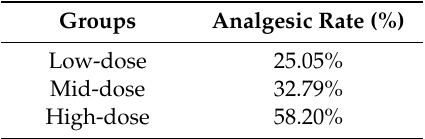
Table 3. The analgesic rate of wICM in the acetic acid